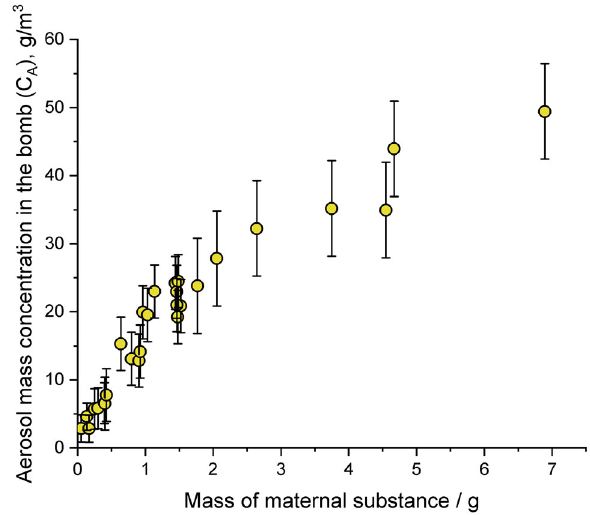
Fig. 11 Aerosol mass concentration in the bomb versus blowing time. Symbols—experimental values, solid line follows Eq. (3)